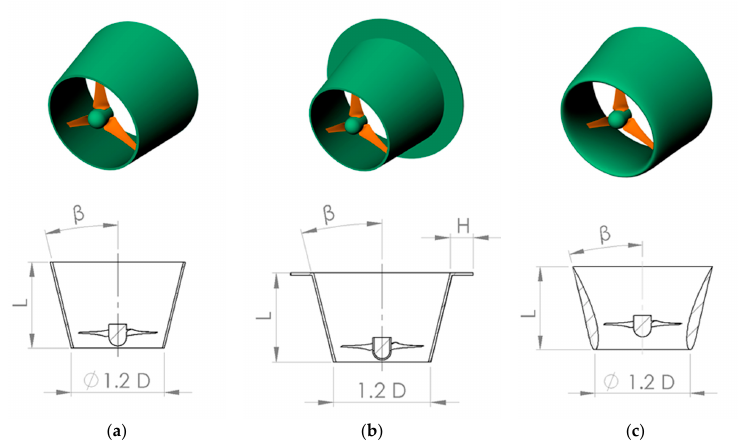
Figure 4. Representation of diffusers’ geometrical configurations: ( a ) Diffuser configuration DF; ( b ) Diffuser configuration DFB; ( c ) Diffuser configuration DFN. Table 1. Design parameters of diffusers.